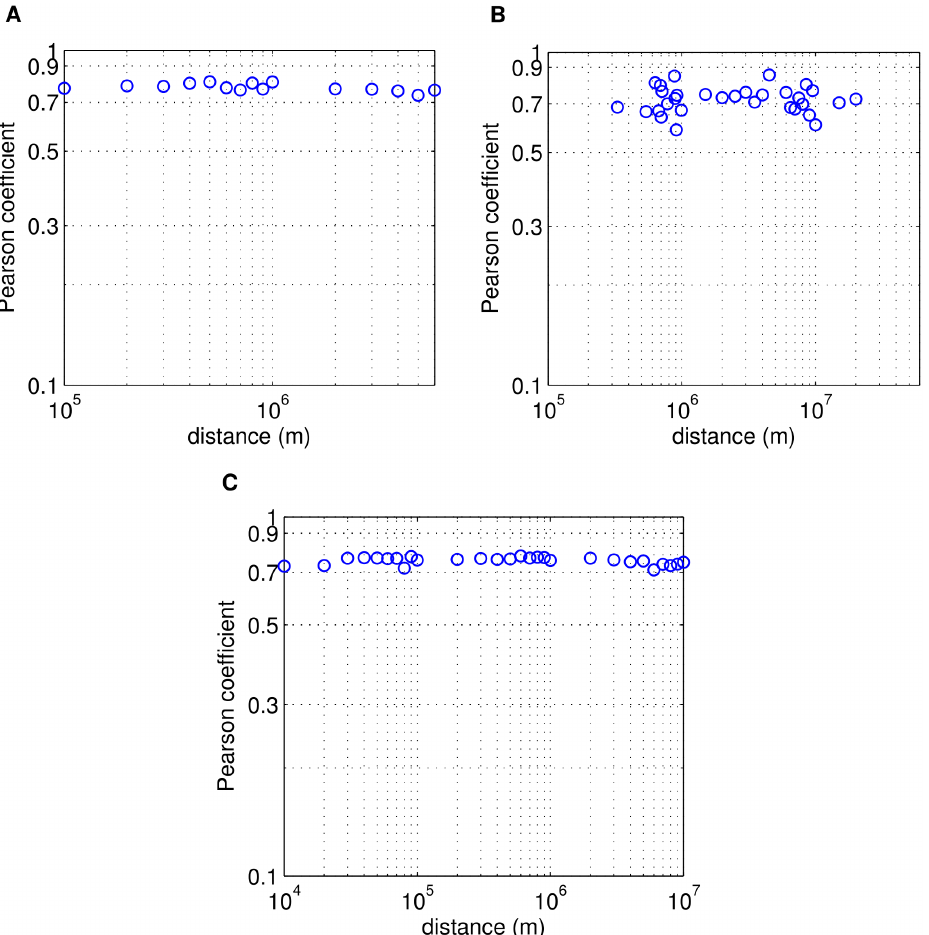
Figure 5. Spatial independence of the population growth rates. The mean correlation coefficient S c T of the population growth rate as a function of geographical distance (log-log plot). (a) for Renren: plateau at about S c rr T & 0 : 80 , (b) for Twitter: S c tw T & 0 : 73 , (c) for Gowalla: S c gw T & 0 : 76 .